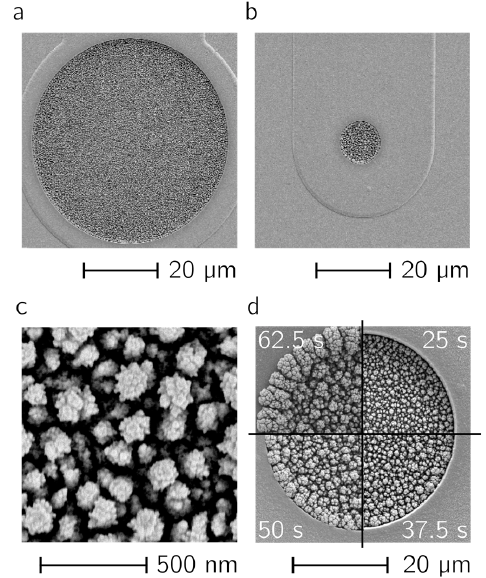
Figure 3. Deposited Pt black. SEM micrographs of deposited Pt black layers. The same deposition parameters have been used for a 50-µm ( a ) and a 10-µm-diameter ( b ) electrode; ( c ) Close up of the Pt black morphology and structure; ( d ) Different total t on times, clockwise from top right: 25 s, 37.5 s, 50 s, 62.5 s for deposition on a 10-µm-diameter electrode.